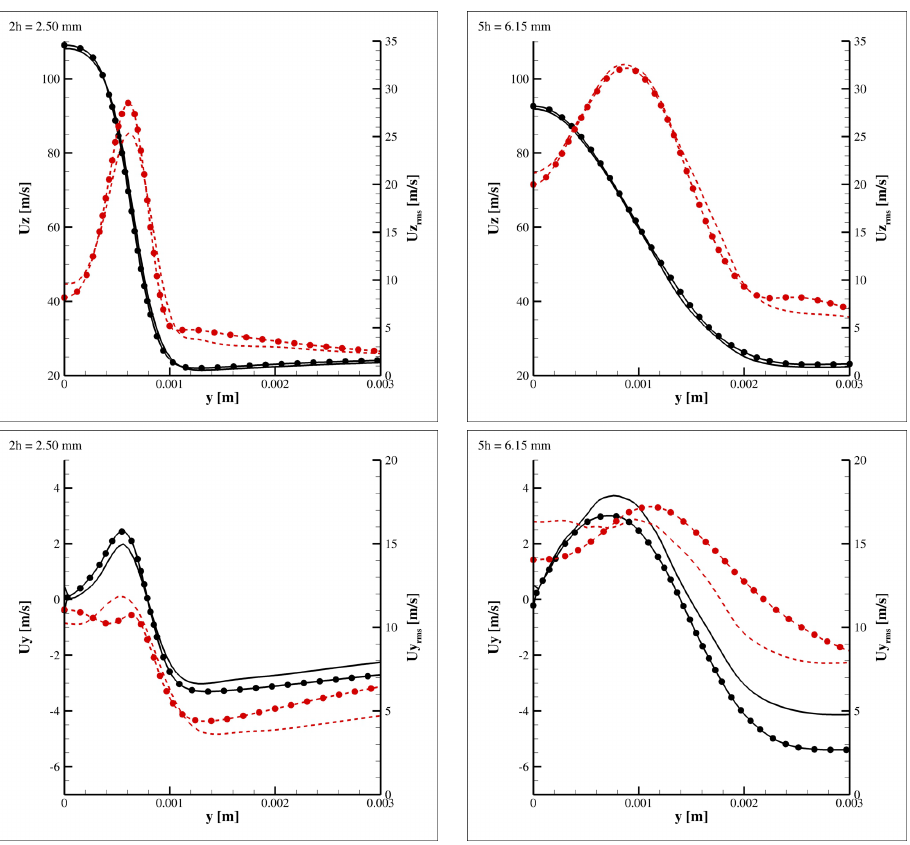
Figure 8. Transversal average (solid lines) and rms (dashed lines) U z and U y velocity profiles at several heights above injection: comparison between LES (lines without symbols) and DNS data (lines with